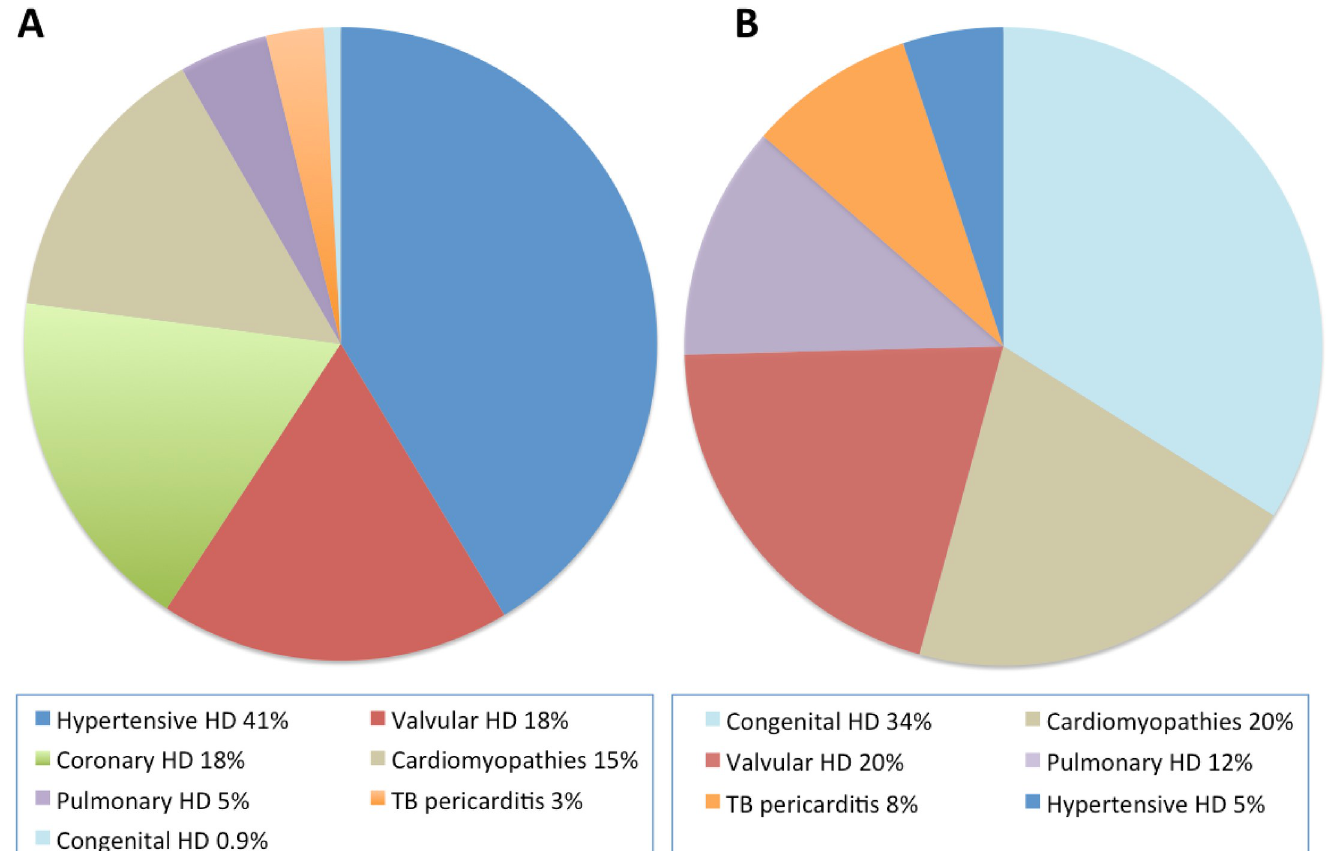
Fig 1. Distribution of heart diseases in adults (A) and in children (B). HD, heart disease; TB, tuberculosis.